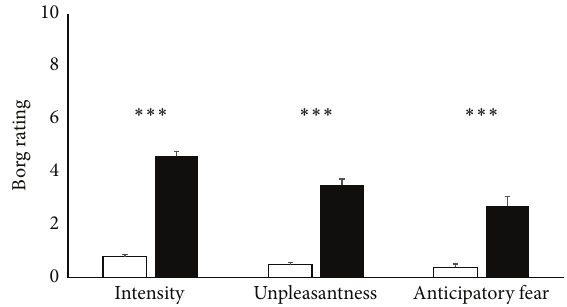
Figure 2: Mean (SEM) ratings of perceived intensity, unpleas- antness, and anticipatory fear for mild (white) and severe (black) dyspnea, respectively. Increases from mild to severe dyspnea were significant at 𝑝 < 0.001 . ∗∗∗ indicates a significance level of 𝑝 < 0.001